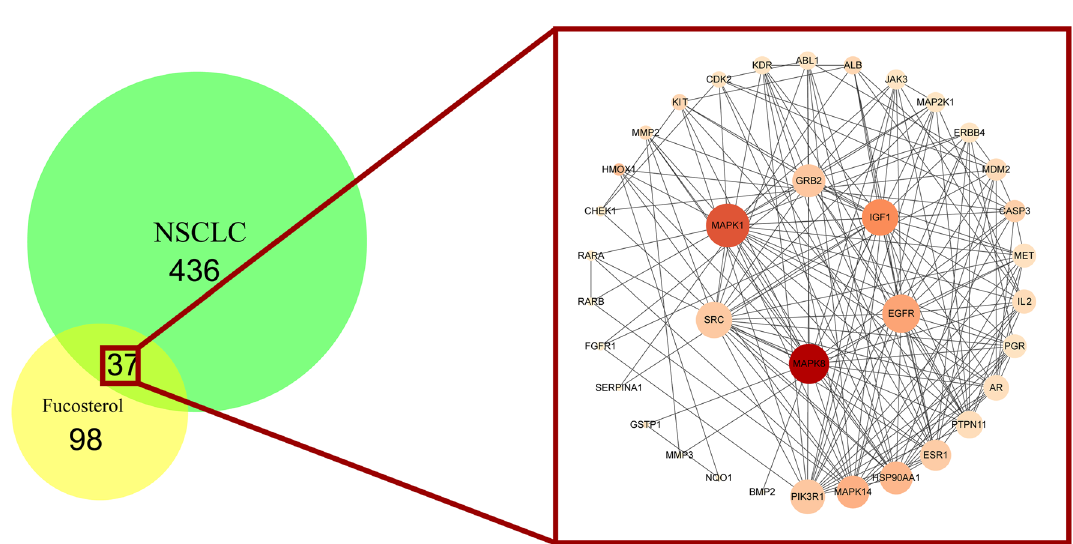
Figure 4. The PPI network constructed for the candidate targets of fucosterol treated NSCLC using Cytoscape3.7.2 (https ://cytos